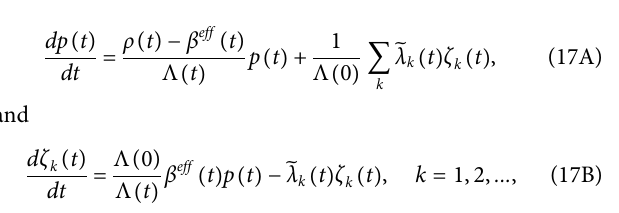
FIGURE 1 | Time step illustration of the AML-PCQM scheme in